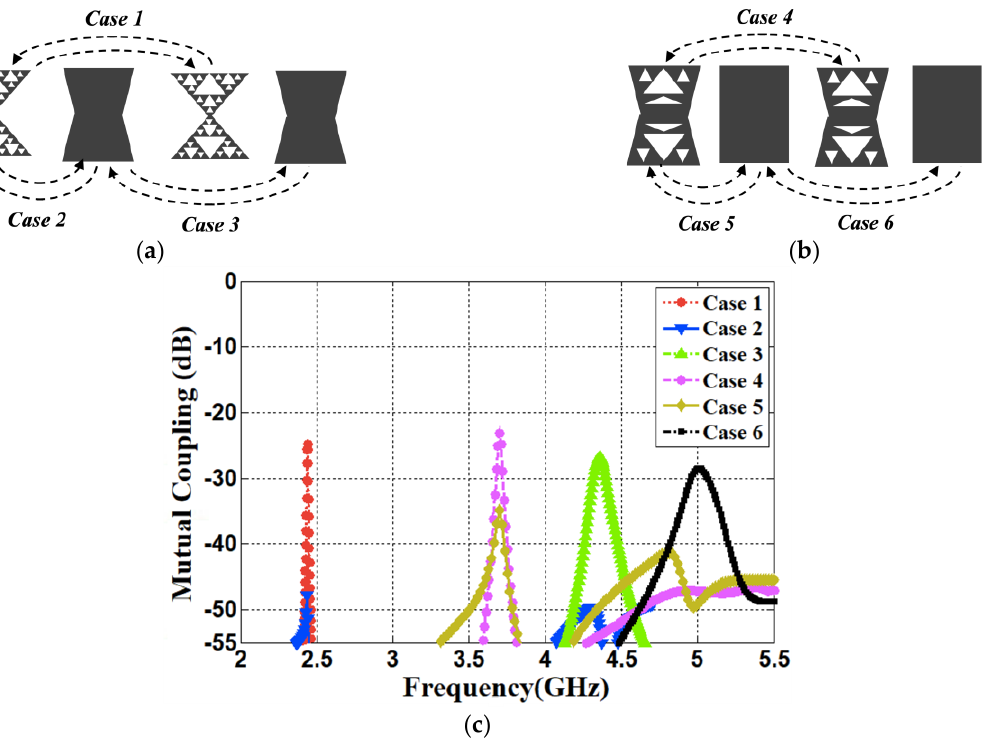
Figure 8. Mutual coupling level between element antennas: ( a ) configuration of mutual coupling in the upper array antenna, ( b ) configuration of mutual coupling in the lower array antenna, ( c ) mutual coupling level between element antennas.